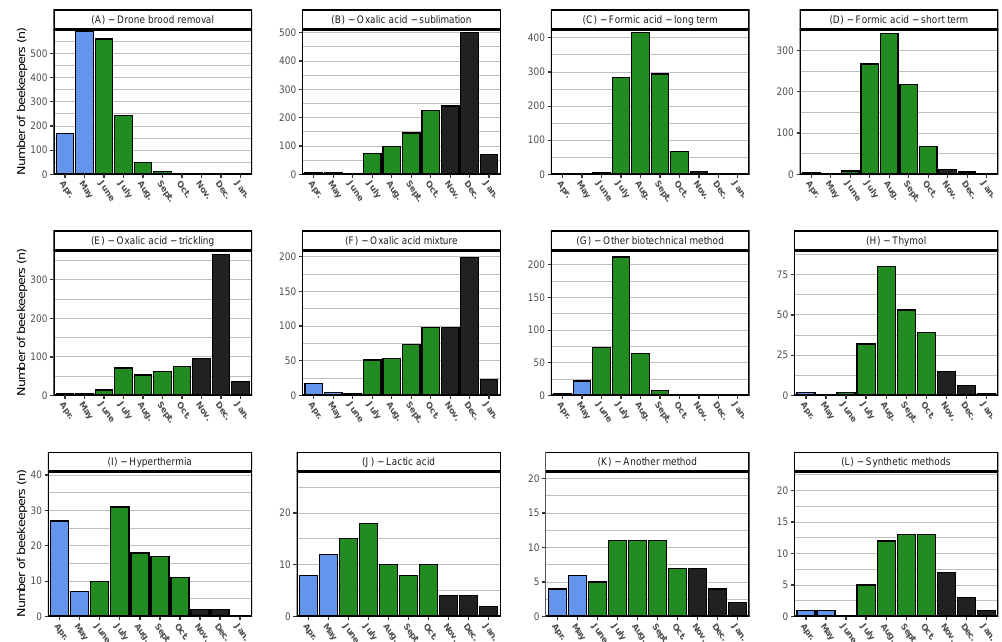
Figure 10. Varroa control methods and their month of usage as histograms starting with April 2018 and sorted by total frequencies. ( L ) “Synthetic methods” are combined and include Amitraz, Coumaphos, and “other synthetic methods”; ( G ) “other biotechnical methods” do not include drone brood removal or hypothermia; and ( K ) “another method" excludes synthetic methods. We defined April–May as spring (blue), June–October as summer (green), and November–January as autumn/winter (black). The months February, March, and April 2019 are excluded. The Y-axis has separate scales for each treatment. n = 1455